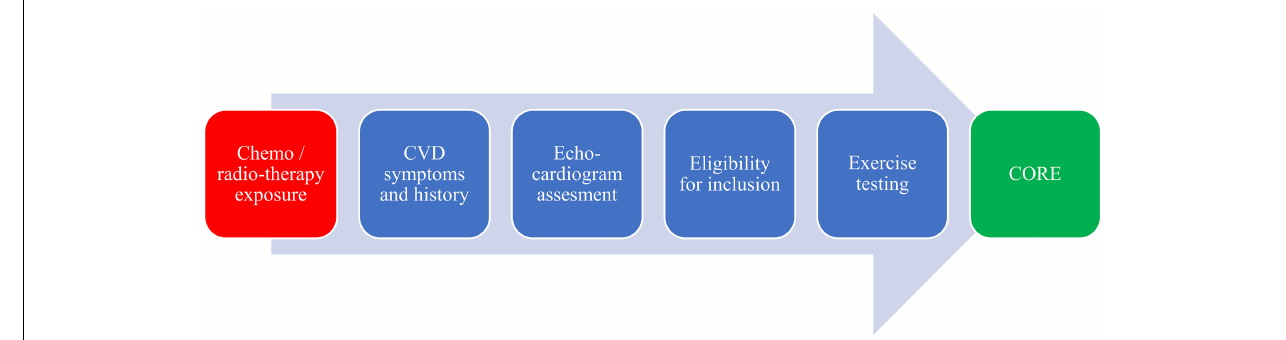
FIGURE 1 | Pre-CORE